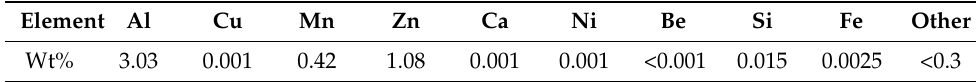
Table 1. Summary of chemical compositions for AZ31B from material specification sheet.